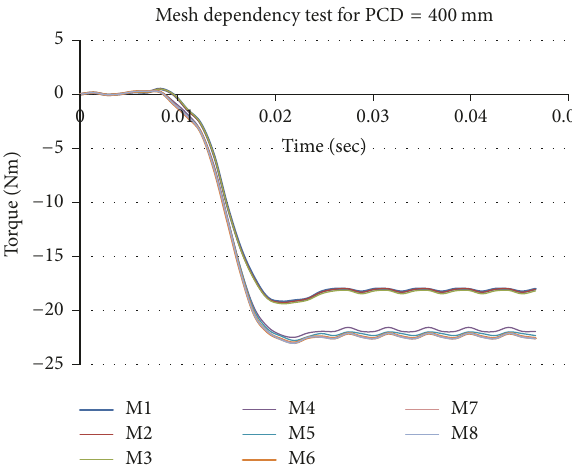
Figure 20: Total torque variations for different mesh sizes for PCD = 400